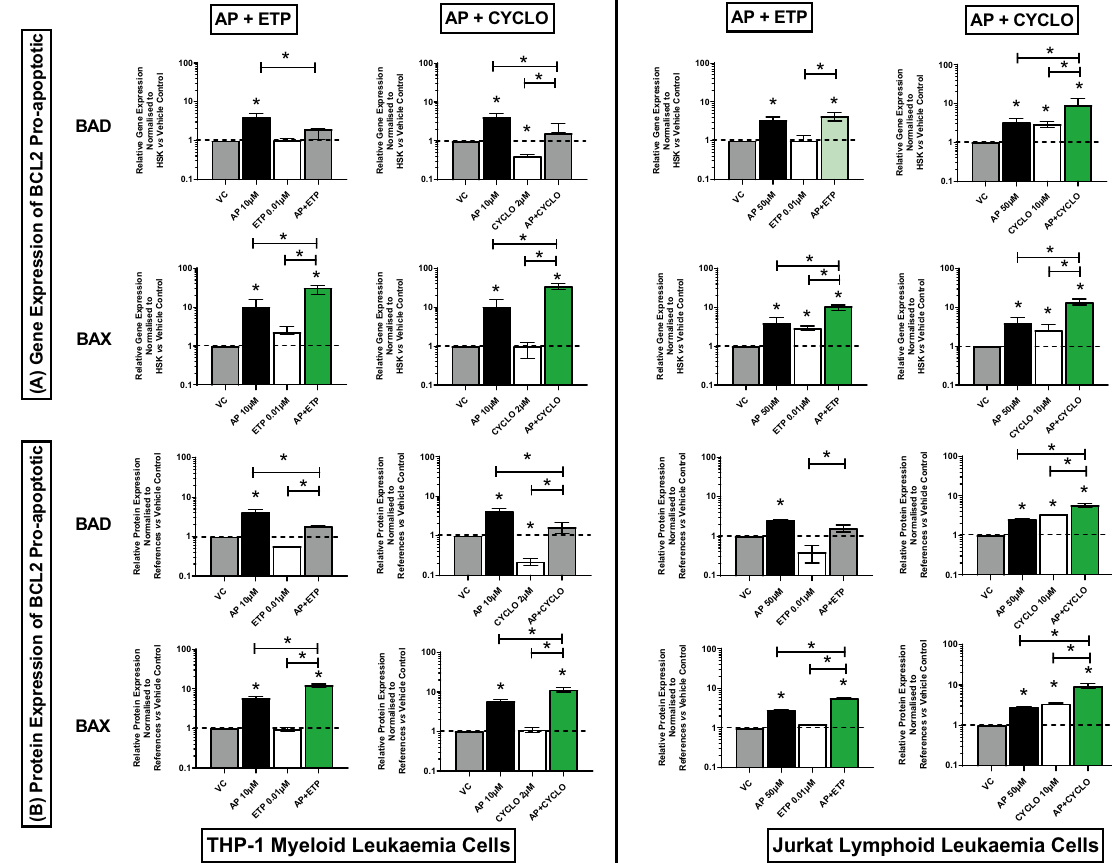
Figure 2. Effects of apigenin (AP) alone and in combination with etoposide (ETP) and cyclophosphamide (CYCLO) on expression of BAD and BAX pro-apoptotic genes ( A ) and proteins ( B ) in acute myeloid (THP- 1) and lymphoid (Jurkat) leukaemia cell lines when treated with their lowest significant doses (LSDs) that induce apoptosis (determined previously in Mahbub et al., 2013, 2015, 2019) for 24 h. Gene and protein data are expressed as medians and ranges. Results were considered statistically significant when P ≤ 0.05 (*). The combination treatment effects and colours were determined based on the statistical analysis described Effect of combination treatments on expression of death receptors/domain genes and pro‑ teins (TRAILR1/DR4, TNFR1/TNFRSF1A, FAS/CD95, FADD). In THP-1 acute myeloid cells, the combination treatment of apigenin and etoposide caused a synergistic increase in TNFR1/TNFRSF1A gene and protein expression, when compared to the vehicle controls and drugs alone (P ≤ 0.05) (Fig. 5A,B) (Supplemen- tary Figs. S1, S2). Whilst, when apigenin was used in combination with cyclophosphamide, although a signifi- cant increase was seen in the expression of TNFR1/TNFRSF1A compared to vehicle controls (P ≤ 0.05) no dif- ference was seen compared to drug treatments alone (Fig. 5A); and protein expression was unchanged (Fig. 5B) (Supplementary Figs. S1, S2) . In THP-1 cells, both combination treatments caused a significant increase in gene and protein expression of TRAILR1/DR4 (Fig. 5) (Supplementary Figs. S1, S2), and gene expression in FAS/ CD95 and FADD, when compared to the vehicle control and/or one of the individual drugs, (P ≤ 0.05); with dif- ferential effects being seen in protein expression of FAS/CD95, and FADD (Fig. 6) (Supplementary Figs. S1, S2). In Jurkat acute lymphoid cells, the combination treatment of apigenin and etoposide caused a significant increase in the expression of all investigated death receptors and domain genes and proteins when compared to the vehicle controls (P ≤ 0.05), no synergistic effects were seen (Figs. 5 and 6) (Supplementary Figs. S1, S2). In contrast, the combination treatment of apigenin and cyclophosphamide, caused a synergistic increase in the expression of TRAILR1/DR4 gene and protein levels, when compared to the vehicle controls and drugs alone (P ≤ 0.05) (Fig. 5A,B) (Supplementary Figs. S1, S2). However, this combination did not cause any significant effect on the expression of TNFR1/TNFRSF1A (Fig. 5A,B) FAS/CD95, and FADD (Fig. 6A,B) genes and proteins (Supplementary Figs. S1, S2). Effect of combination treatments on expression of caspase genes and proteins (CASP‑8, CASP‑9, CASP‑3). In both myeloid and lymphoid leukaemia cell lines, all combination treatments caused a synergistic increase in CASP-9 and CASP-3 gene expression when compared to the vehicle control and drugs alone (P ≤ 0.05) (Fig. 7A). Whilst CASP-8 was significantly increased compared to the vehicle control and chem-